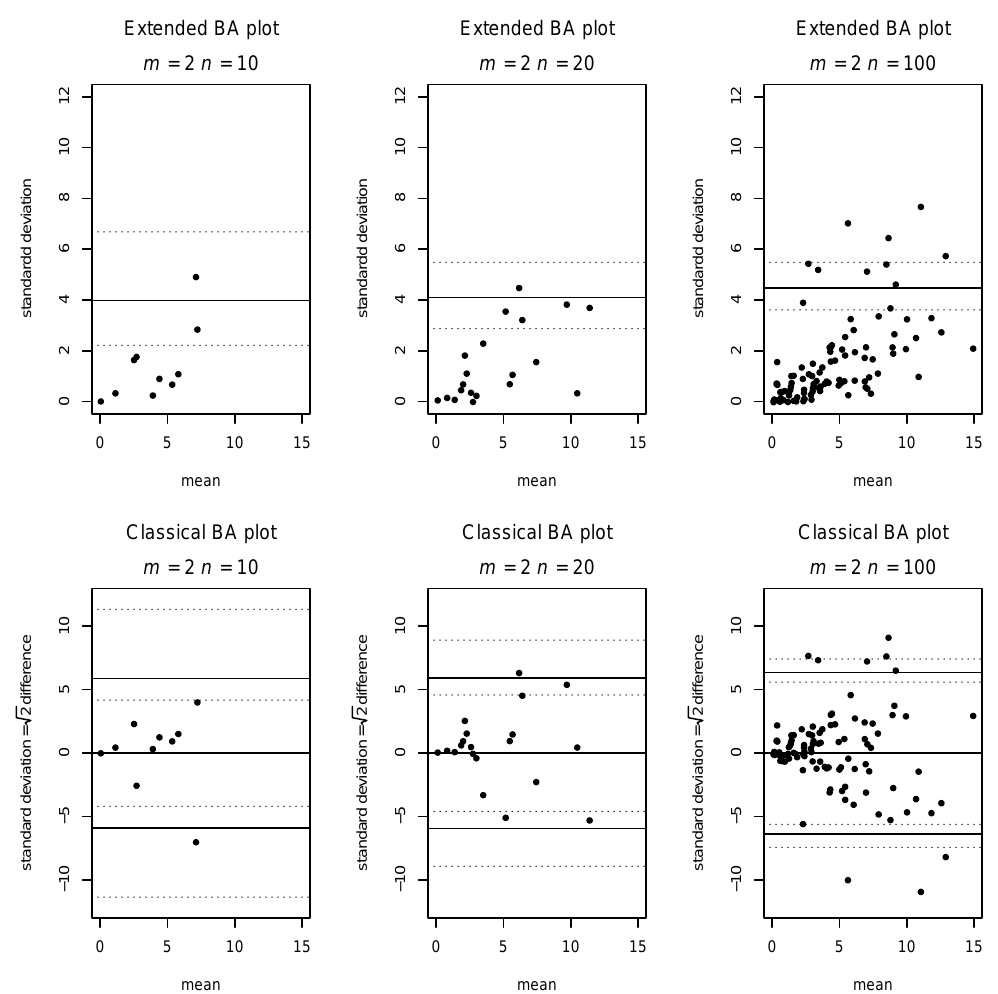
Figure 4. Comparison between the classic and generalized BA plot in a situation where the measurement error increases with the true